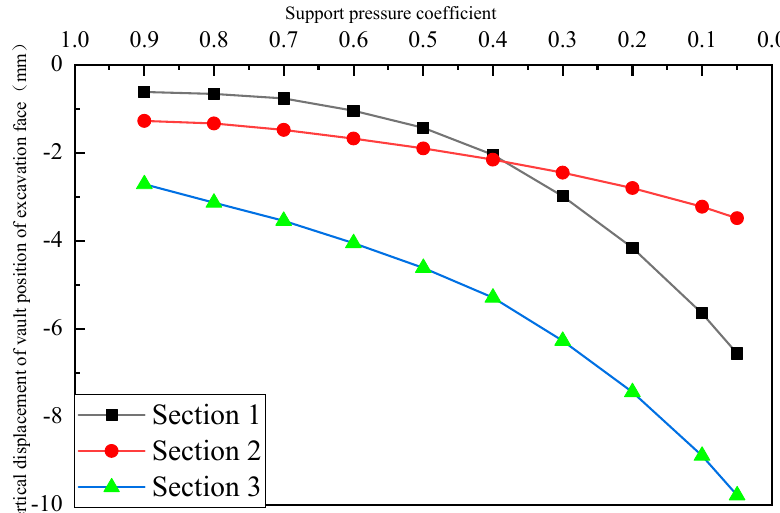
Figure 11. Vertical Displacement of Excavation Face under Different Supporting Pressure Coefficients.